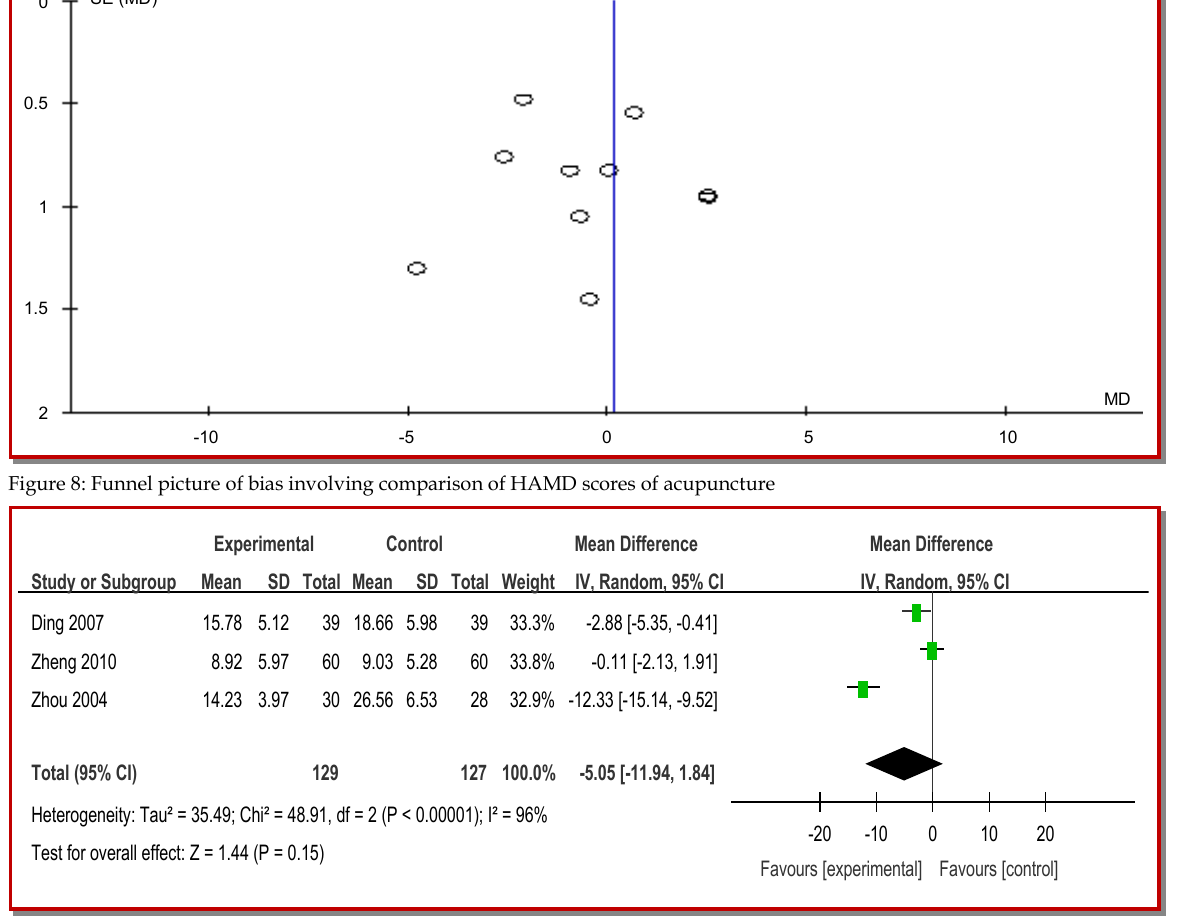
Figure 9: Meta-analysis of the studies evaluating KMI score of